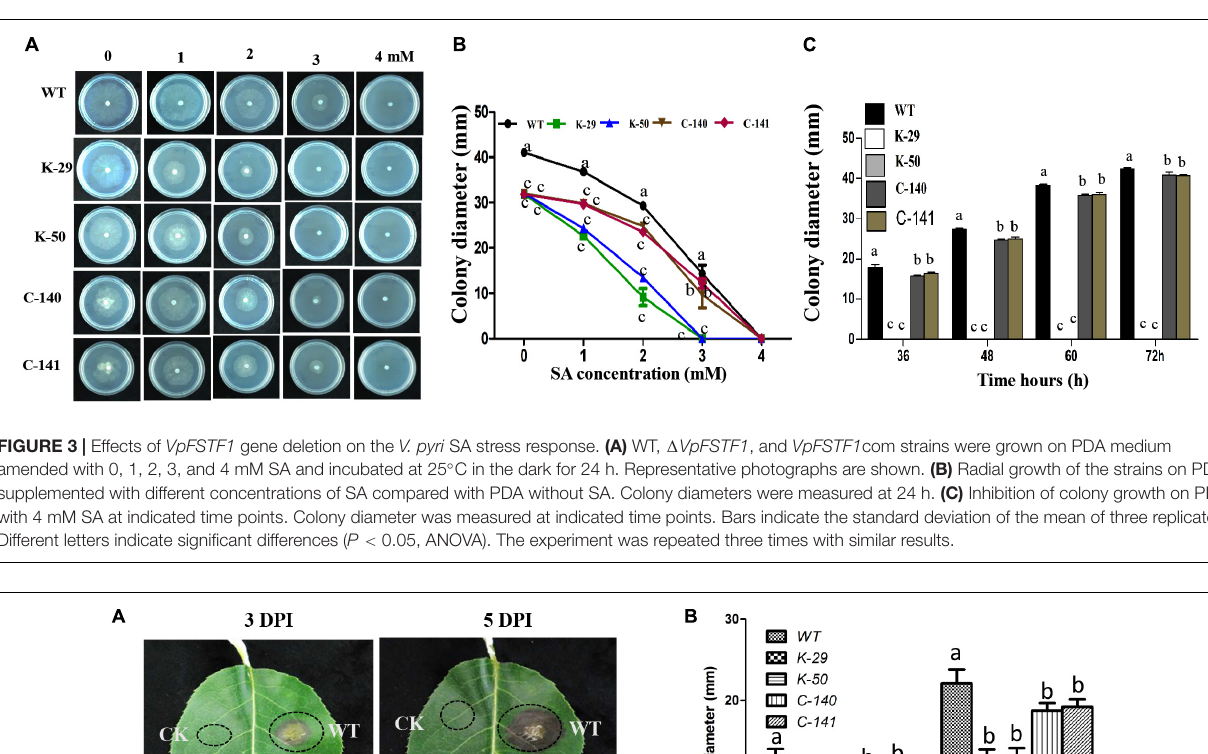
1993 upregulated and 2006 downregulated DEGs in the K-50 mutant ( Figure 5B